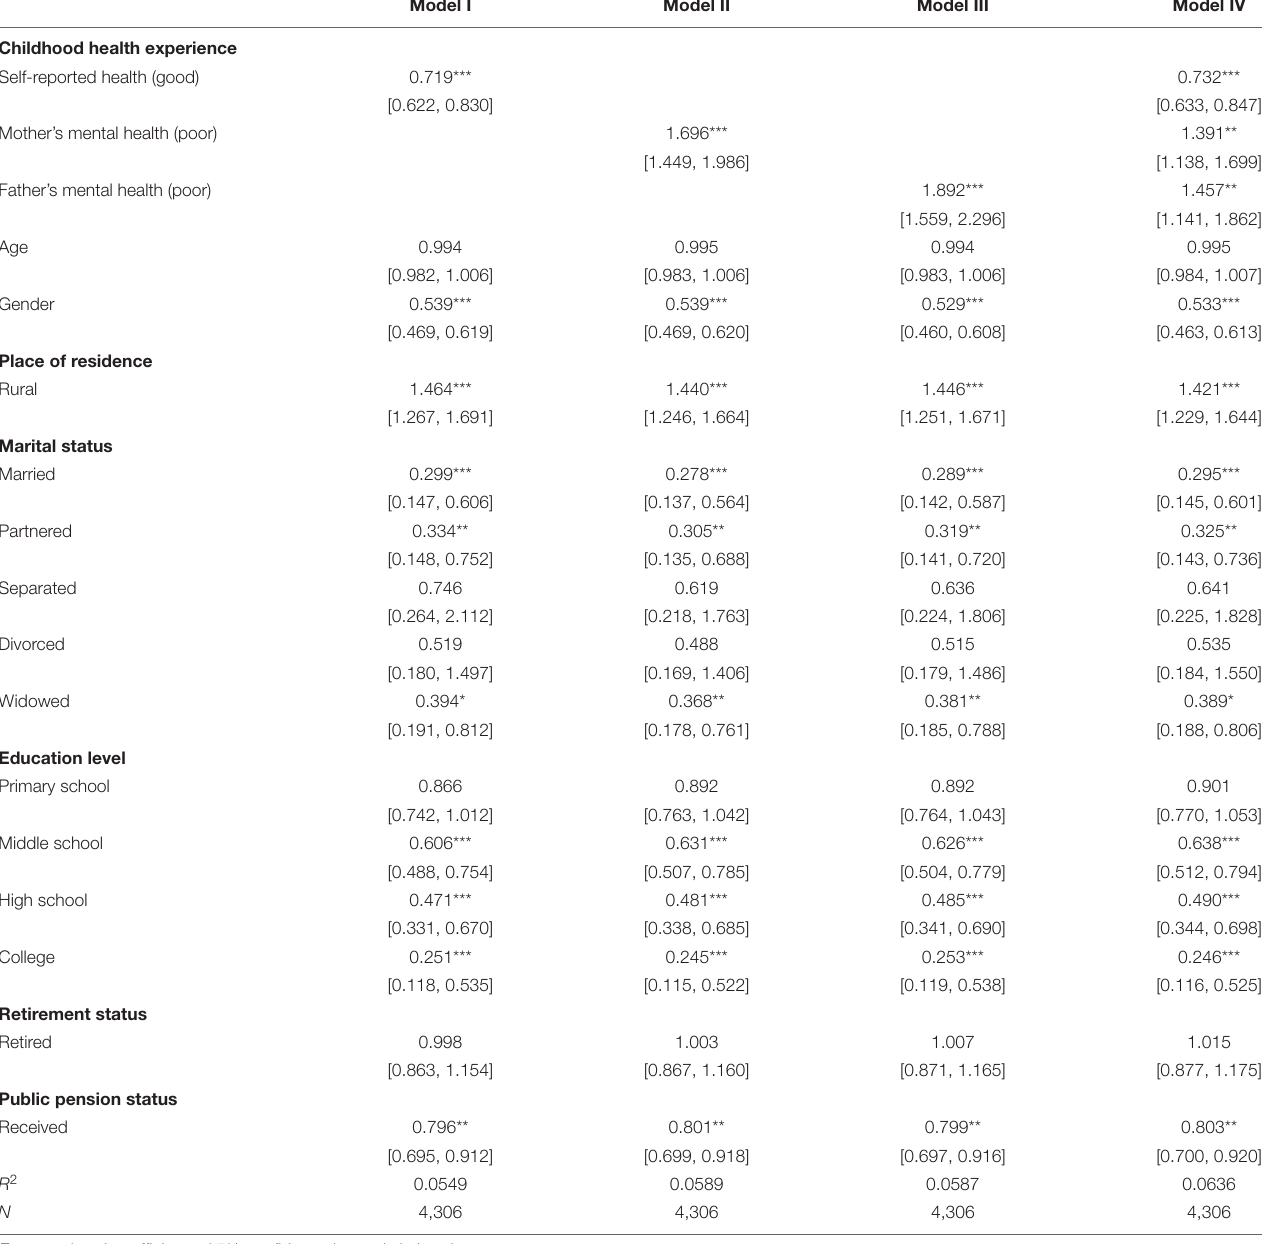
TABLE 2 | Associations between childhood self-reported health, parental mental health and depression among Chinese older